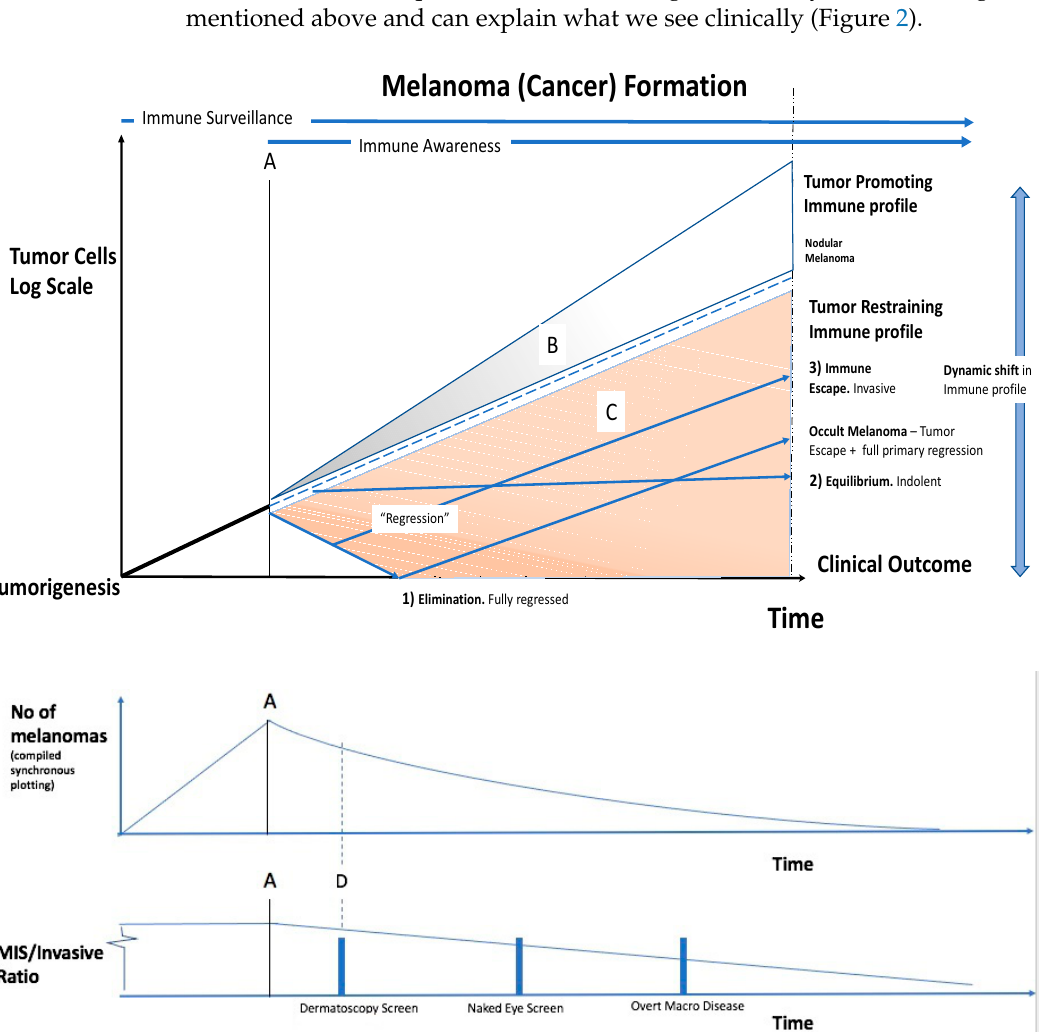
Figure 2. Model of the immune—cancer interaction. Melanoma tumorigenesis involves proliferating aberrant melanocytes with reduced contact inhibition, and with growing dis-cohesiveness in a multicellular organism. The immune system surveillance detects the tumour at (A). If the immune system is ‘tumour- promoting’, the upper grey part of the diagram (B) becomes operational. The tumour